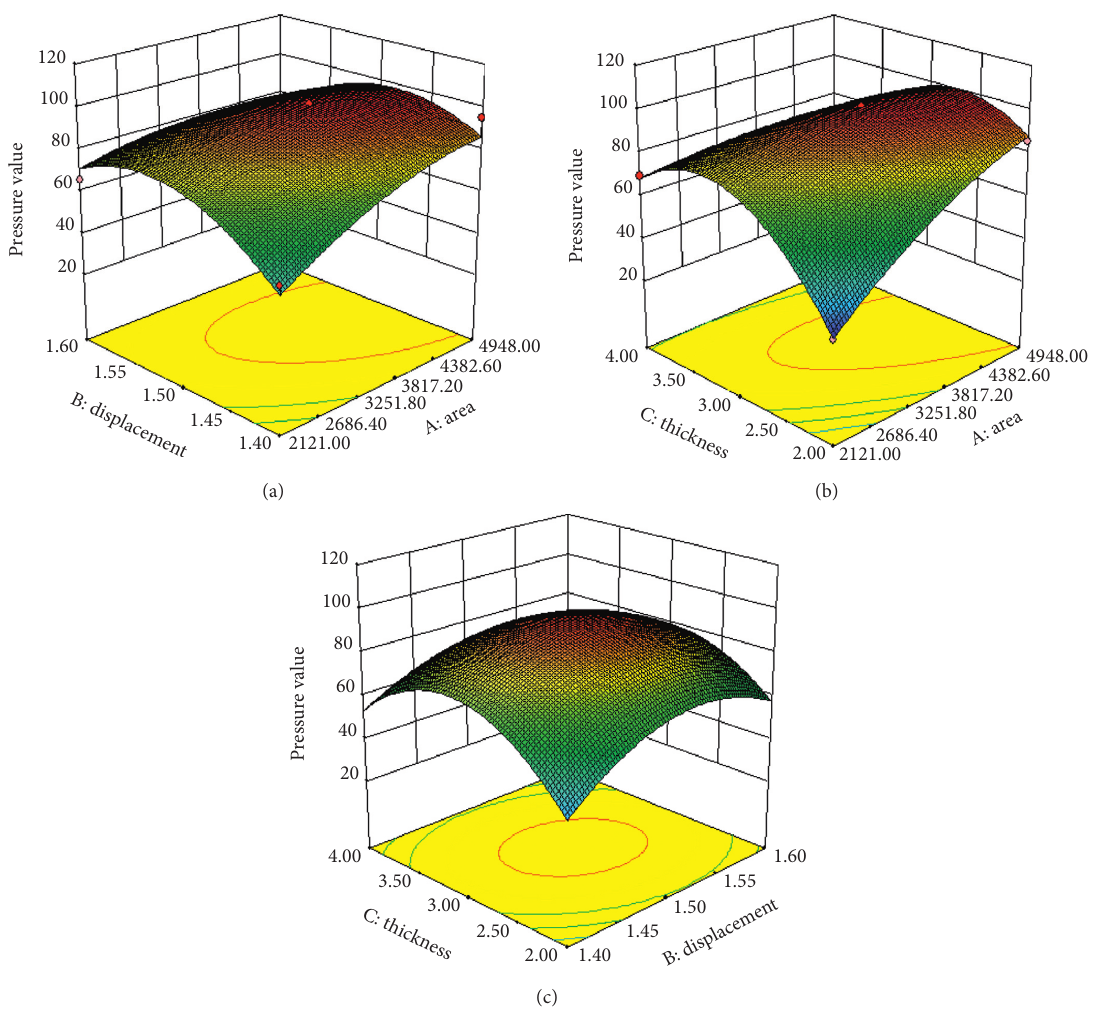
Figure 9: Effect of experimental parameters on the pressure value. (a) Effect of area and displacement. (b) Effect of area and thickness. (c) Effect of thickness and